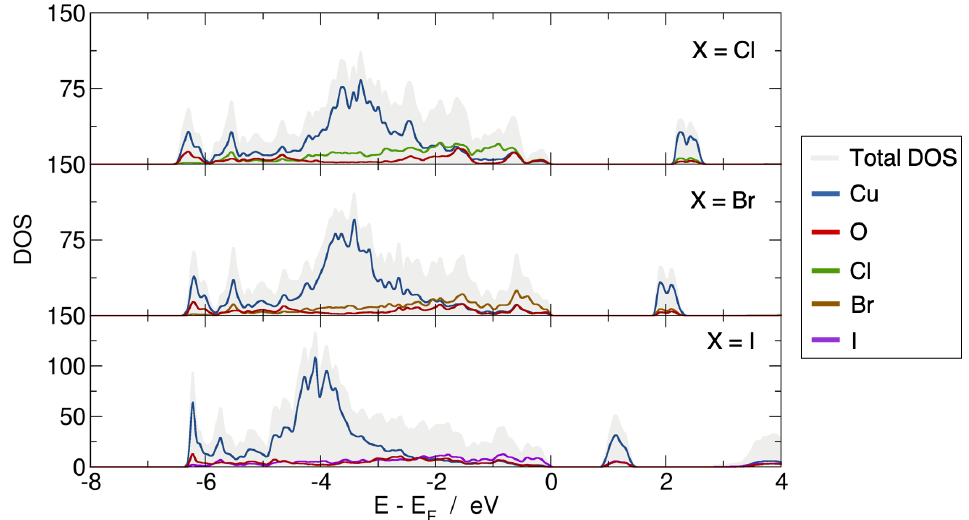
Figure 2. Total and projected densities of states for the Cu 2 OX 2 compounds (X = Cl, Br, I) deduced from PBE0 on-site calculations on the ground-state AFM collinear order. Energies for pDOS are given with respect to E F .